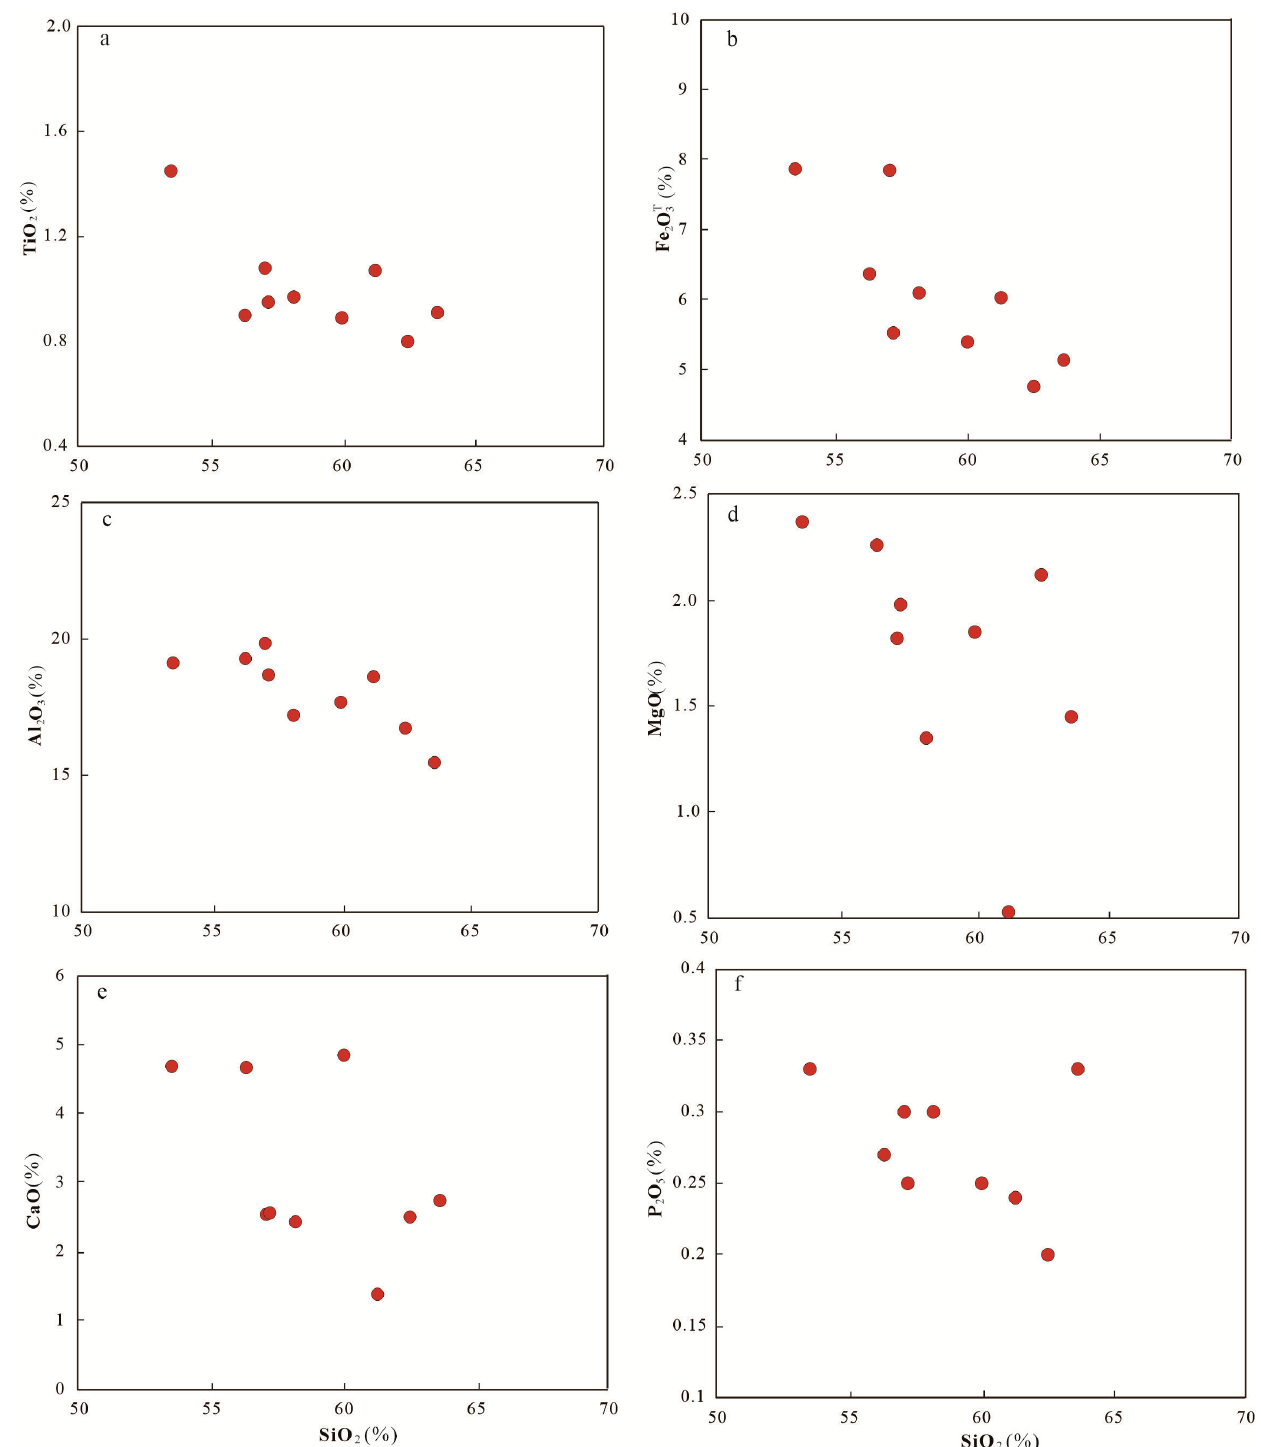
Figure 7. Harker diagram of Late Jurassic mafic volcanic rocks from Badaguan area. ( a ) TiO 2 vs. SiO 2 diagram; ( b ) Fe 2 O 3 vs. SiO 2 diagram; ( c ) Al 2 O 3 vs. SiO 2 diagram; ( d ) MgO vs. SiO 2 diagram; ( e ) CaO vs. SiO 2 diagram; ( f ) P 2 O 5 vs. SiO 2 diagram.